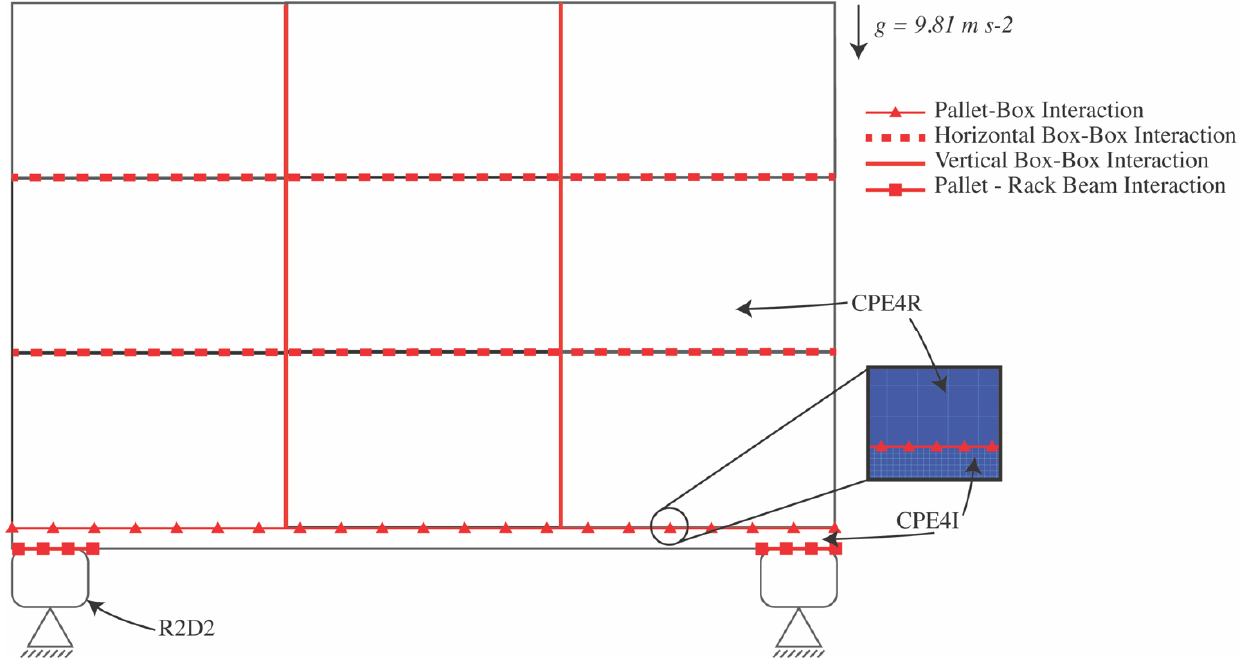
Figure 6. Schematics of the two-dimensional finite element model with the corresponding contact interactions and mesh properties.